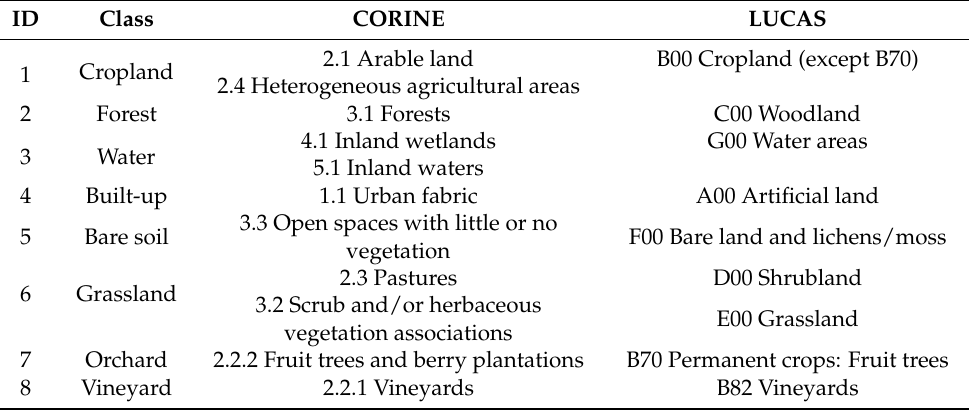
Table 3. Description of the major LC classes used in this research, with included codes of CORINE Level 2/3 and LUCAS classification